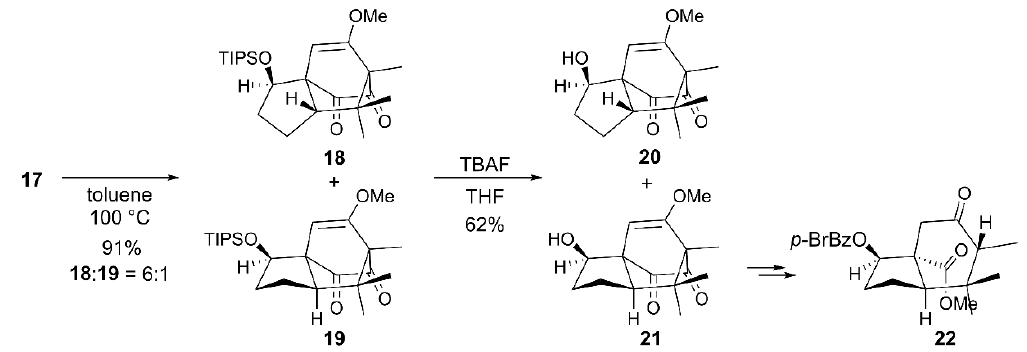
Scheme 3. IMDA reaction of ortho ‐ benzoquinone 17 .